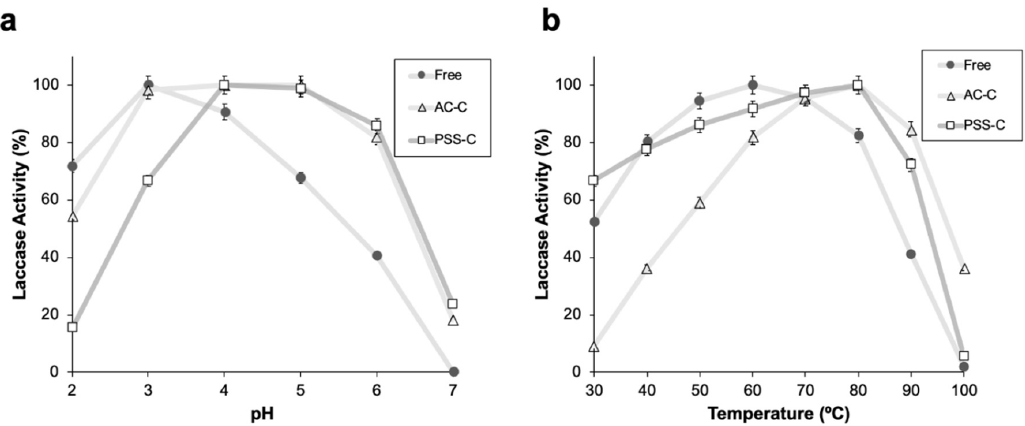
Figure 5. ( a ) pH and ( b ) thermal stability measurements for free laccase ( • ), AC-C ( ∆ ), and PSS-C ( (cid:3) ). For free laccase, a maximum activity was observed at 60 ◦ C, with an approximately linear decrease for temperatures above 80 ◦ C and below 40 ◦ C. For encapsulated laccase, the maximum activity shifted to temperatures of about 80 ◦ C. Error bars correspond to standard deviations of experiments conducted in triplicate.